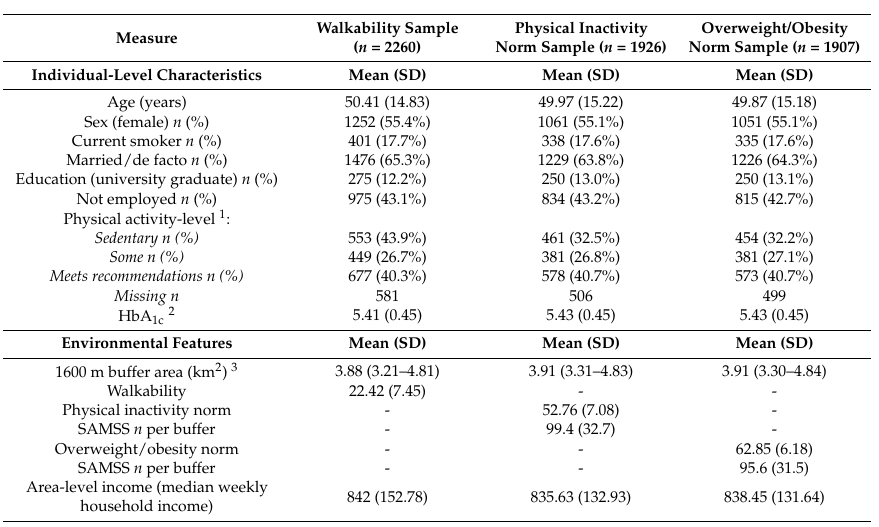
Table 2. Characteristics of individuals (baseline) and environmental features (Wave 2) for the three analysis samples.